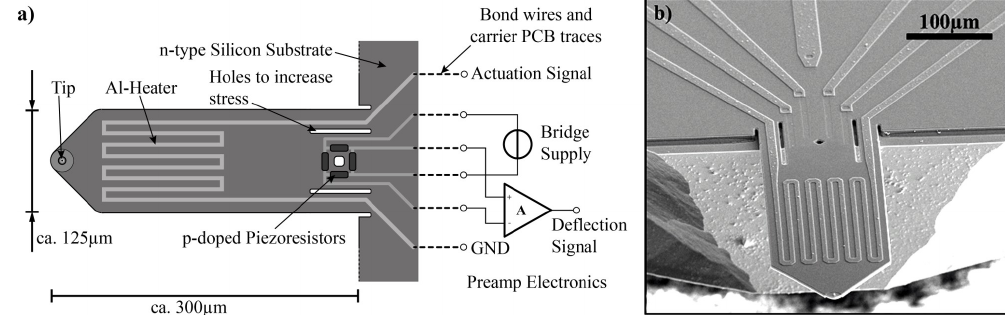
Figure 1. Active probe design ( a ) schematic illustration of the active probe with thermomechanical actuation and piezoresistive sensing, ( b ) SEM image of a fabricated active probe before